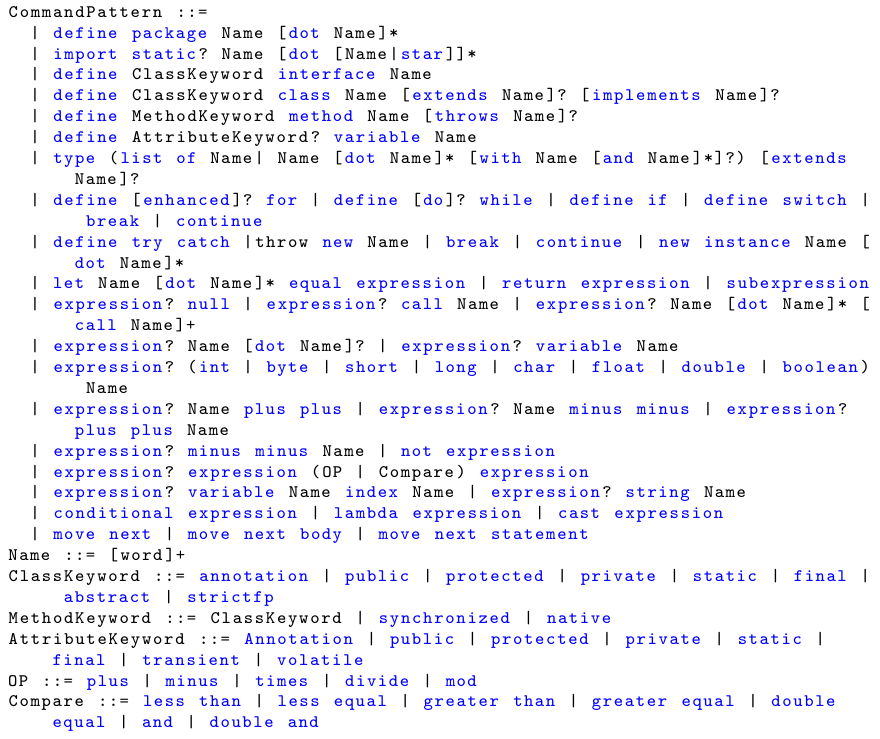
Figure 2. Architecture overview.